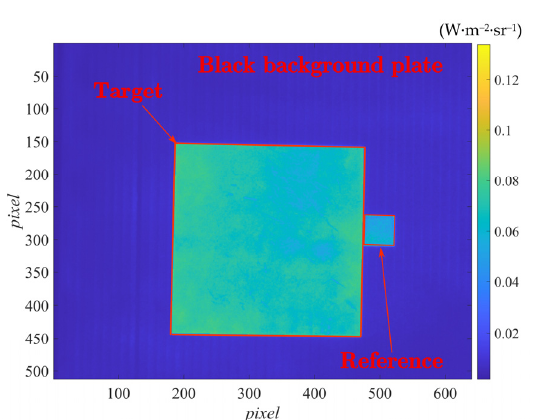
Figure 8. Radiance difference image obtained under irradiation combination i .